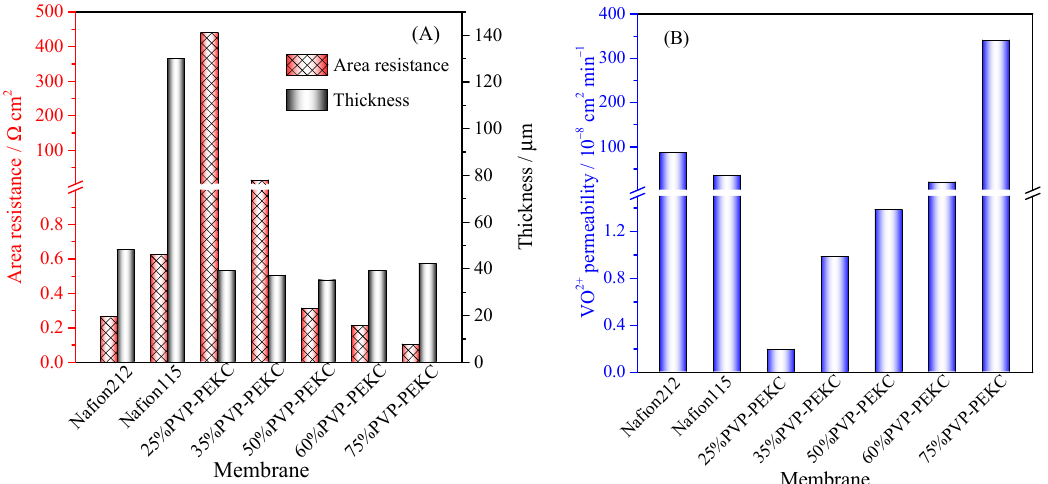
Figure 7. ( A ) Area resistance and thickness and ( B ) vanadium ion permeability of various membranes after immersing in 3 M H 2 SO 4 at RT.